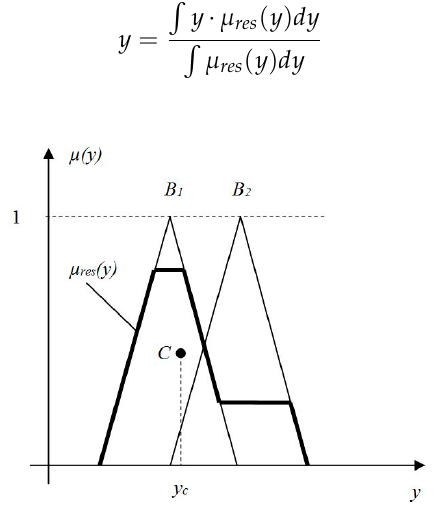
Figure 5. Defuzzification by the centre of gravity